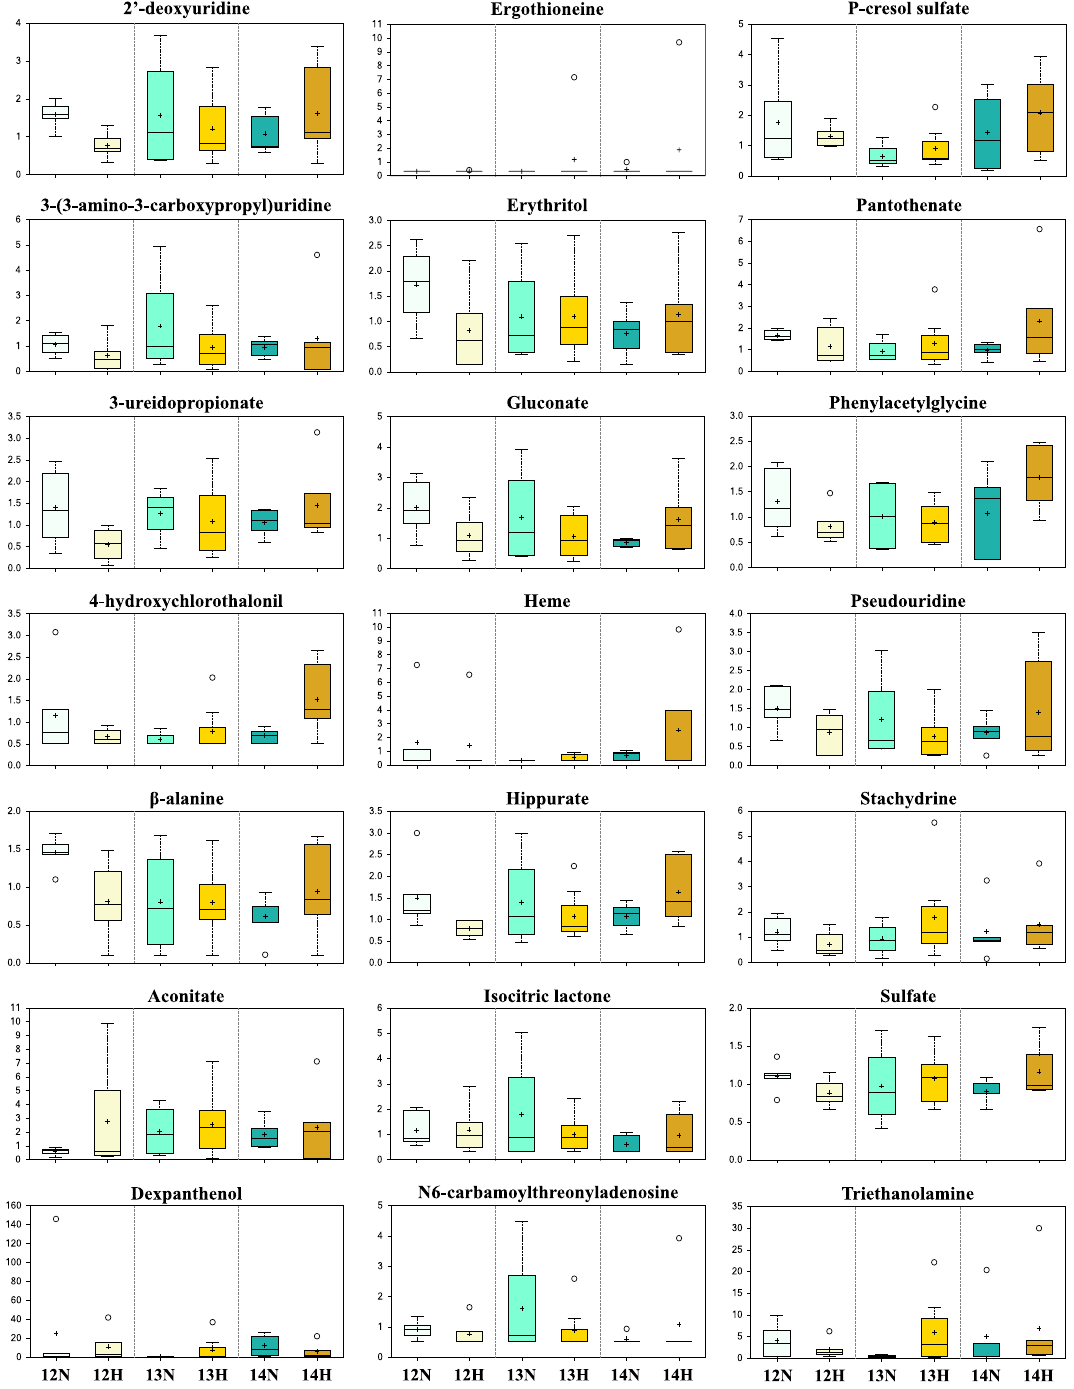
Figure 8. Scaled intensity boxplots of additional metabolites identified in this study. The y-axes are the relative metabolite concentrations, with the central horizontal line representing the median value with outer boundaries depicting upper and lower quartile limits. Error bars depict the minimum and maximum distributions, with + representing the mean value and ○ the extreme data